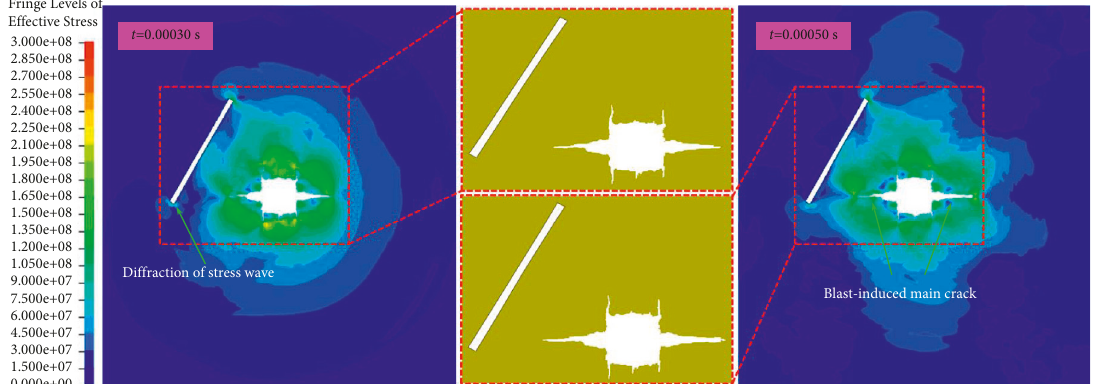
Figure 9: Pressure diagram of explosion stress wave transmission for case CN